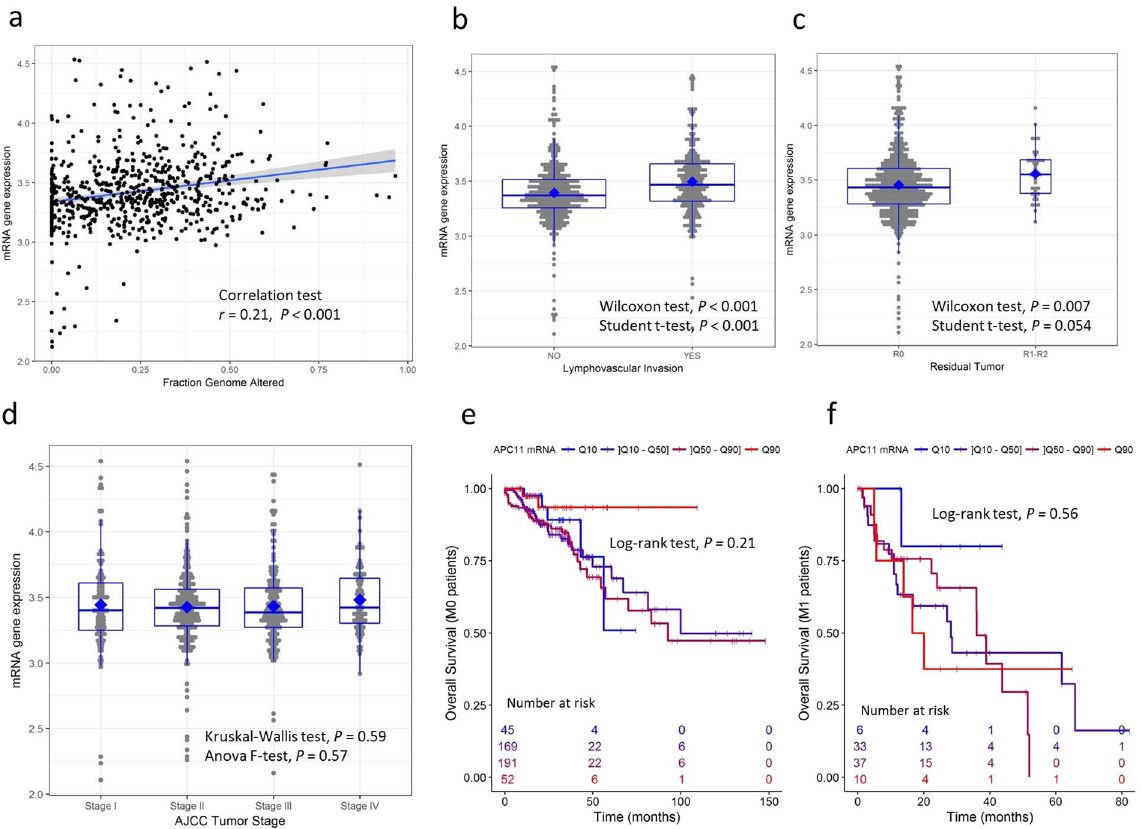
Figure 3. APC11 mRNA expression in primary CRC from the TCGA repository and statistical correlations with clinical and biological features. Data of the TCGA READ cohort (rectum adenocarcinoma, N = 174) and the TCGA COAD cohort (colon adenocarcinoma, N = 499) were combined. ( a ) APC11 mRNA expression according to the fraction of genome altered (FGA) calculated with a threshold value of 0.2. The coefficient of correlation r is displayed with the corresponding P value. The regression line from a linear model (blue line) and its 95% confidence interval (grey area) are also displayed. Panels ( b – d ) show respectively the APC11 mRNA expression according to lymphovascular invasion, residual tumor status, and AJCC tumor stage. Panels ( e – f ) show the Kaplan-Meier curves of overall survival according to APC11 mRNA expression stratified using quantiles, for patients with M0 disease (N = 457, panel e) and patients with M1 disease (N = 86, panel